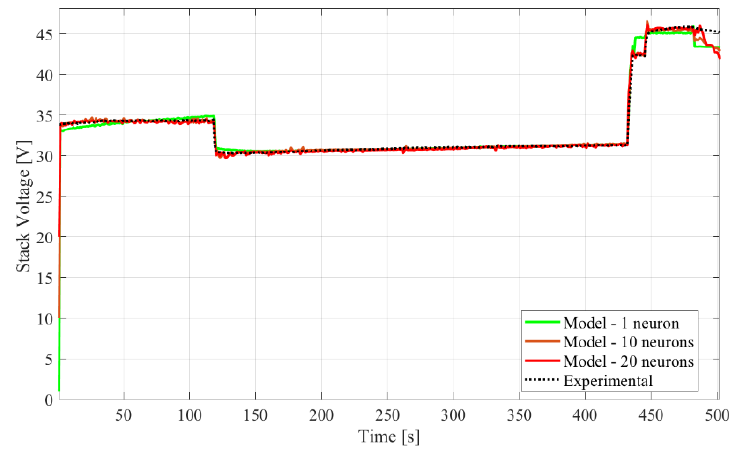
Energies 2022 , 15 , x FOR PEER REVIEW Figure 6. Experimental and model responses of the stack voltage using an ANN with the LM algorithm.